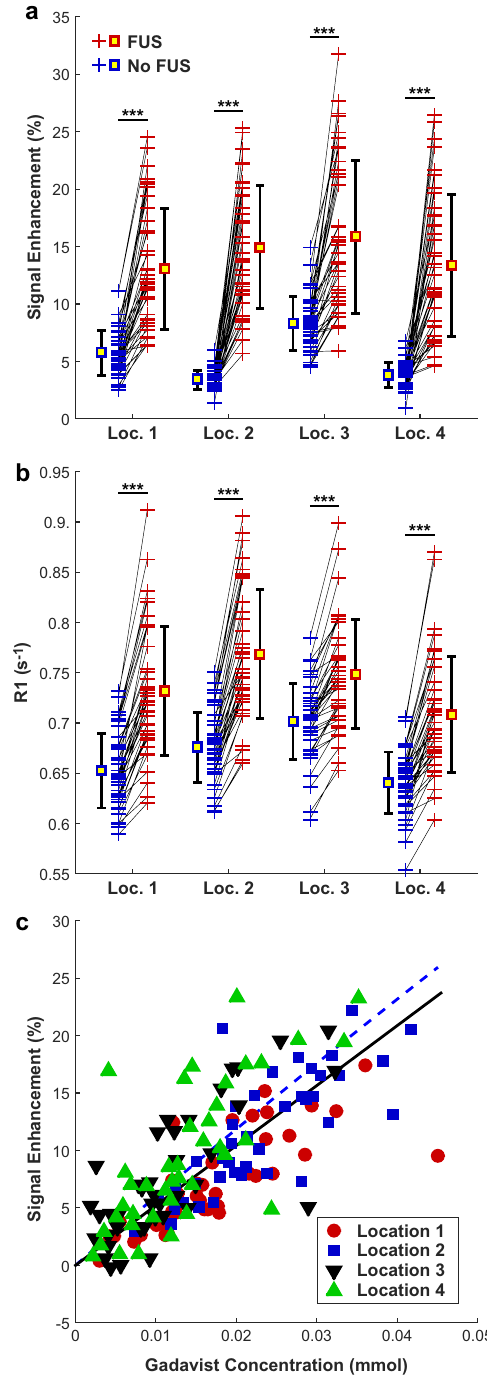
Figure 5. ( a ) Mean changes in MRI signal intensity in T1-weighted imaging after Gadavist injection for the four sonicated locations and the corresponding non-sonicated targets in the contralateral hemisphere for all rats and FUS sessions. The signal change was greater in the sonicated hemisphere in all but one of the sonicated locations. ( b ) Mean R1 relaxation time measured in these four locations. In every case, R1 was larger in the sonicated hemisphere. ( c ) Plot showing the change in signal enhancement in T1-weighted imaging as a function of the Gadavist concentration, which was estimated from the difference in R1 between the sonicated and non- sonicated hemispheres and the relaxivity of the contrast agent (4.44 s − 1 · mM − 1 ). The solid line shows the results of a linear regression through zero (R 2 : 0.53). The dotted line shows the expected signal intensity change in this range of Gadavist concentrations, based on the equation for the signal intensity of a spin-echo sequence, the sequence parameters, and the R1 and R2 values of brain tissue. ( *** P <